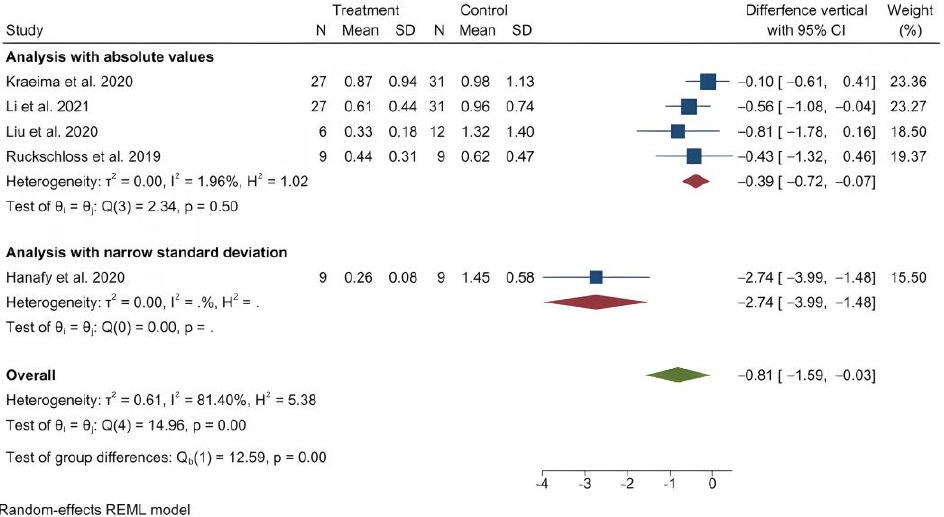
Figure 11. Forest plot showing differences in vertical deviation between PSI and control (conventional osteosynthesis and CAD/CAM splint or wafer).